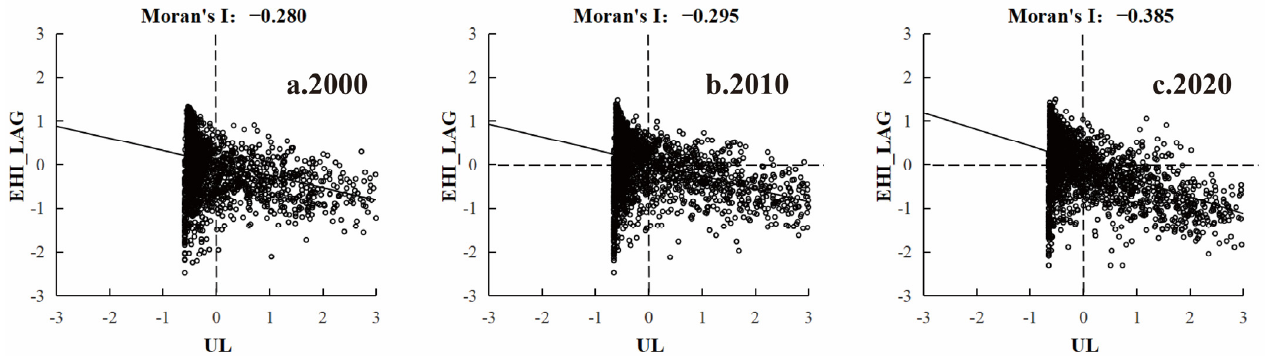
Figure 6. Global Moran’s I between the UL and EHI in the GBA, 2000–2020.